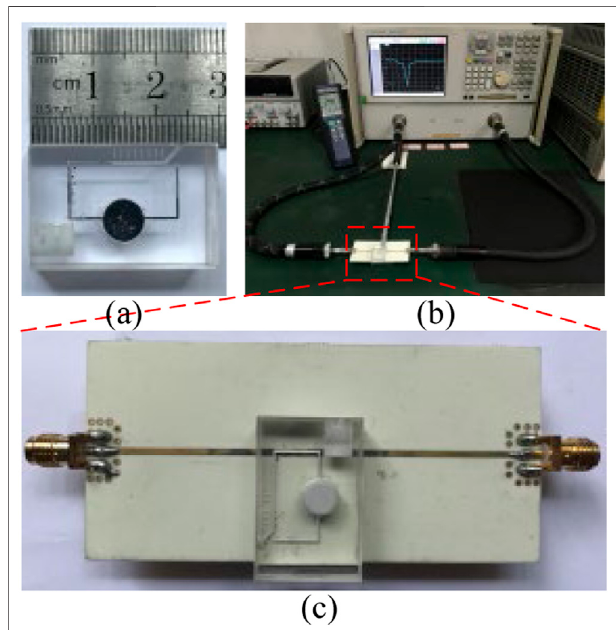
FIGURE 4 | (A) Fabricated rectangular-shape Hg Fano resonator prototype, (B) prepared whole measurement setup for the temperature sensingperformancedemonstration,and (C) zoomedinplotfortheprototype over the microstrip line.